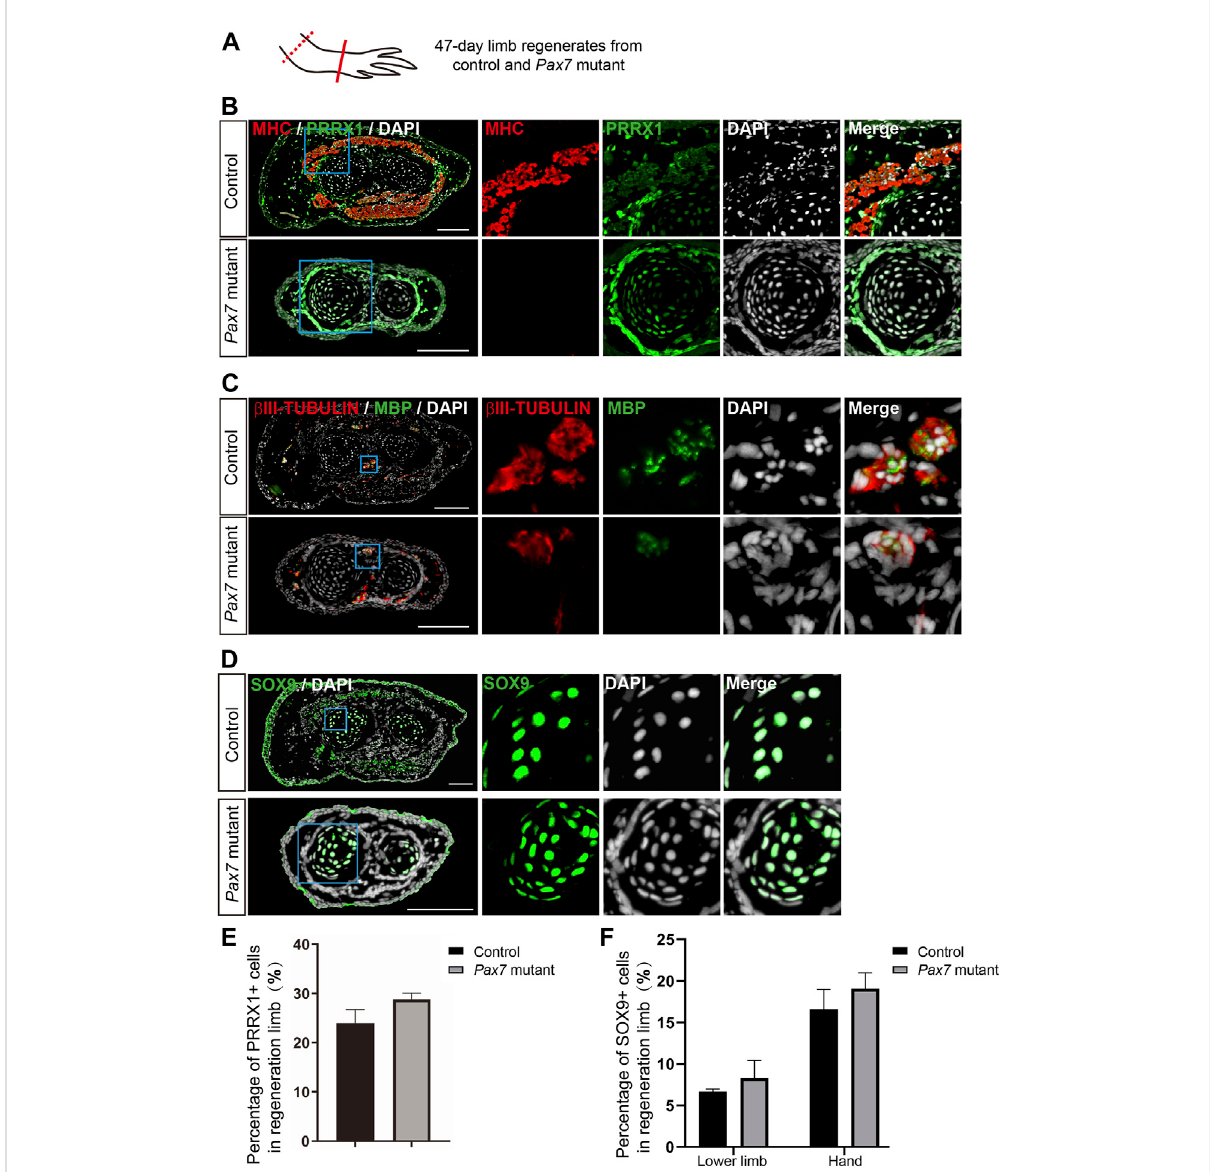
FIGURE 5 Examination of cell types in limb regenerates in Pax7 mutants. (A) Scheme of the sample collection. Dotted line, amputation plane; line, the position of analyzed section. (B – D) Immuno fl uorescence images of MHC (red), PRRX1 (green) and DAPI (white) (B) ; β III-TUBULIN (red), MBP (green) andDAPI(white) (C) ;andSOX9(green)andDAPI (D) ,incross-sections,from47-daysfullyregeneratedcontroland Pax7 mutantlimbs.Boxedregions are shown at higher magni fi cation as separated channels. Scale bars, 200 μ m. (E,F) Quanti fi cation of the percentage of PRRX1 (E) and SOX9 (F) positive cells, in the limb from controls ( n = 3) and Pax7 mutants ( n = 3). Data are presented as mean ±